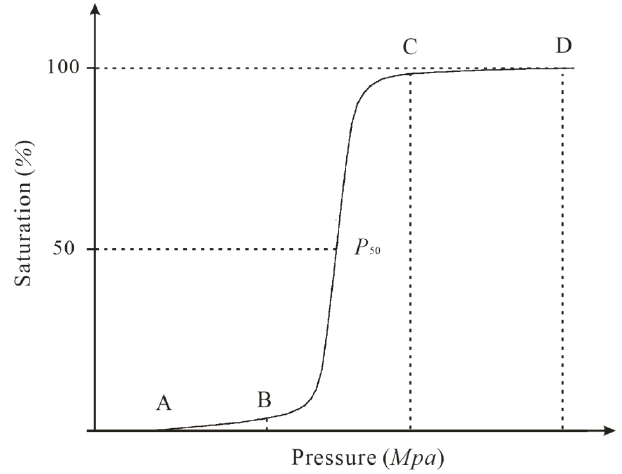
Figure 7. Variation of the pressure with the saturation for four per- meable stones with different particle